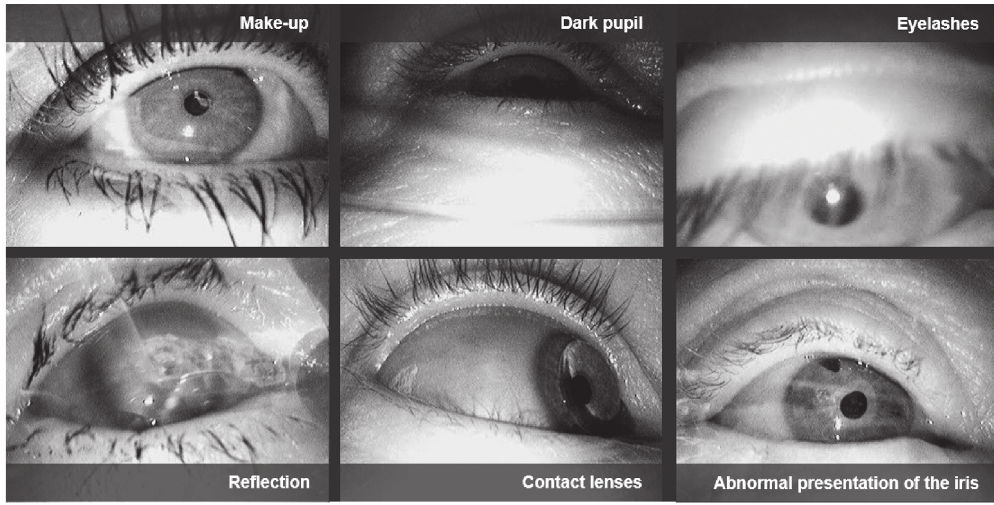
Figure 1: Eye images recorded by mobile, head-mounted eye-trackers in outdoor